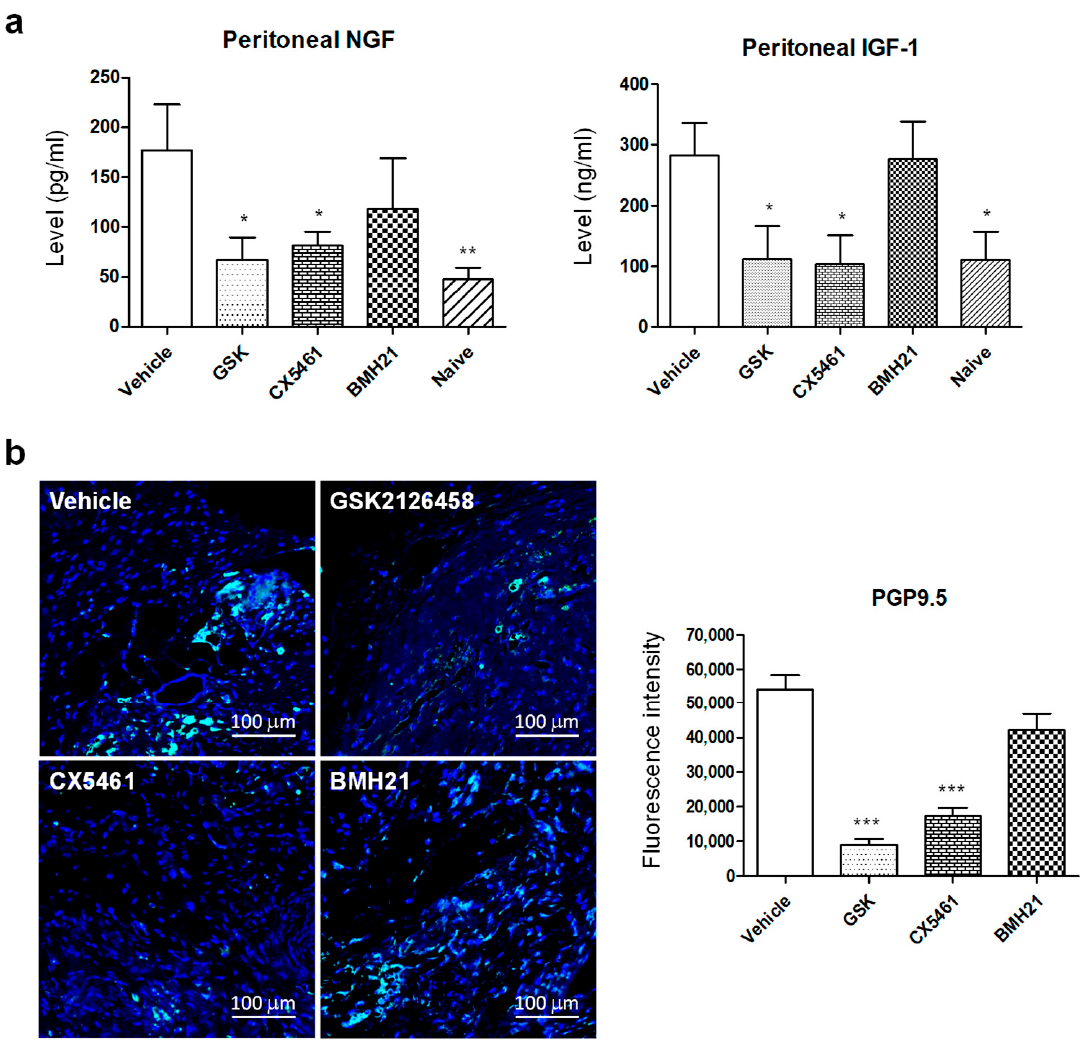
Figure 4. Regulation of nerve fiber growth in endometriotic lesions of mice with induced endometriosis. ( a ) The protein levels of NGF ( left ) and IGF-1 ( right ) in the peritoneal fluid were analyzed by sandwich ELISA. The data were normalized with the average levels in mice treated with vehicle ( n = 15 for each group). ( b ) Immunofluorescence staining was performed to detect the presence of nerve fibers (PGP9.5 + ) in endometriotic lesions from different groups ( left ). The fluorescence intensity was averaged by using data from 10 independent tissue sections ( right ). Statistical differences between vehicle and drug-treated groups were compared by t -test. The p values were presented as *: p value < 0.05, **: p value < 0.01, and ***: p value < 0.001.